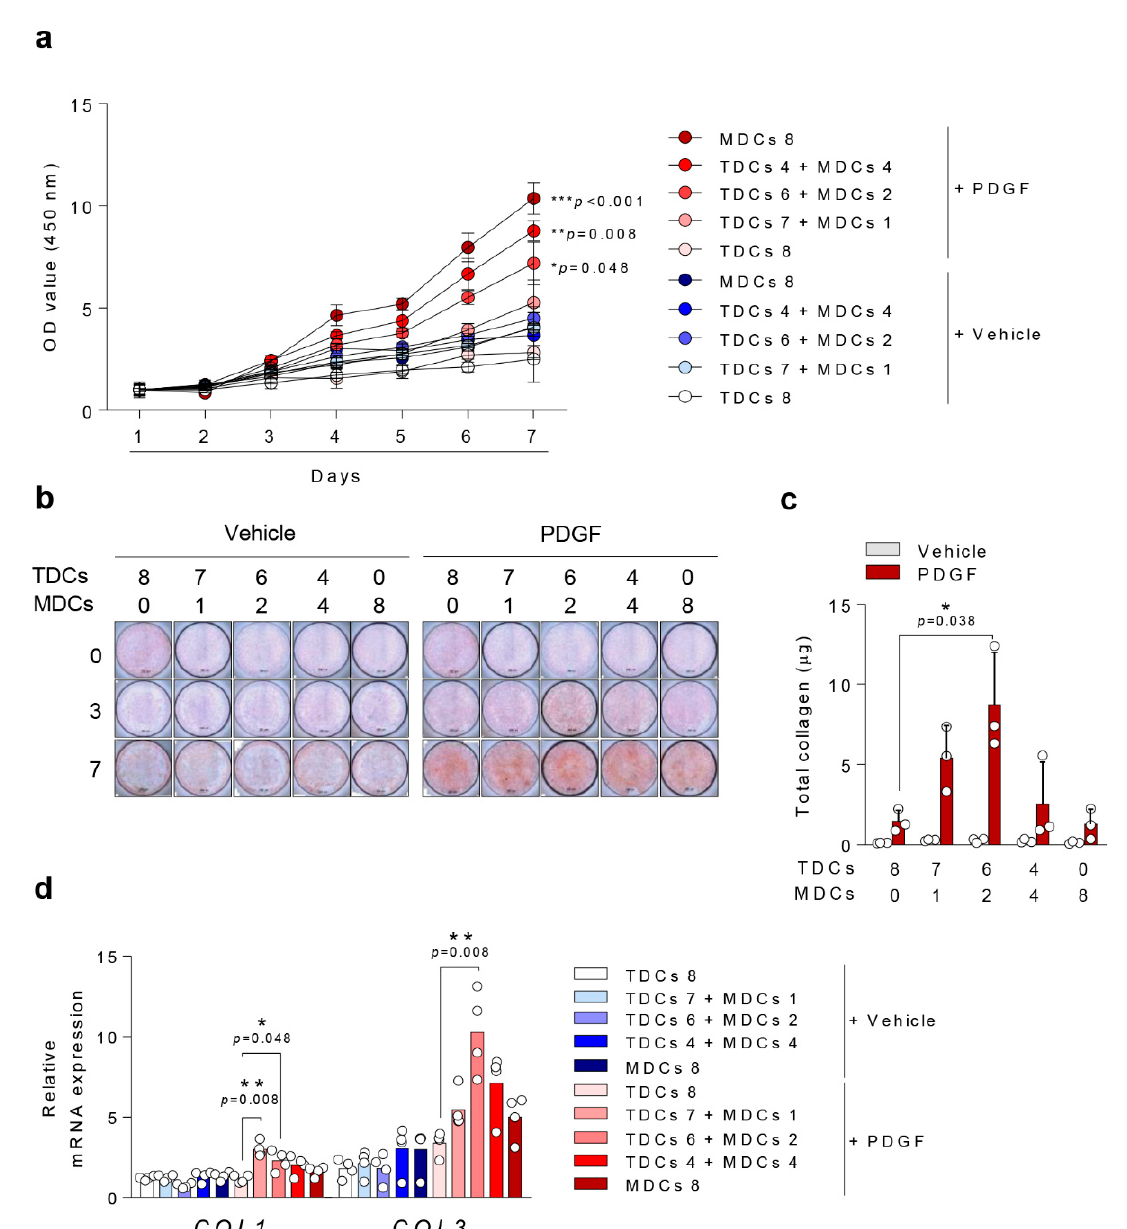
Figure 2. Platelet-Derived Growth Factors-BB (PDGF-BB/PDGF) potentiates ligamentous differentiation in TDCs with small population of MDCs. ( a ) A total of 4 × 10 3 cells (TDCs and/or MDCs, as indicated) were cultured in growth medium for seven days and cell viability was measure using WST assay. A total of 8 × 10 4 cells/well were seeded in six-well plates, stimulated with vehicle or PDGF-BB for 14 days, and analyzed by ( b ) Sirius red staining (scale bar = 200 µm) for collagen type 1 and 3, ( c ) total collagen assay, and ( d ) qPCR for collagen type 1 and 3 gene expressions. *, p < 0.05; **, p < 0.01; ***, p < 0.001. Data are presented as the mean ± SEM.